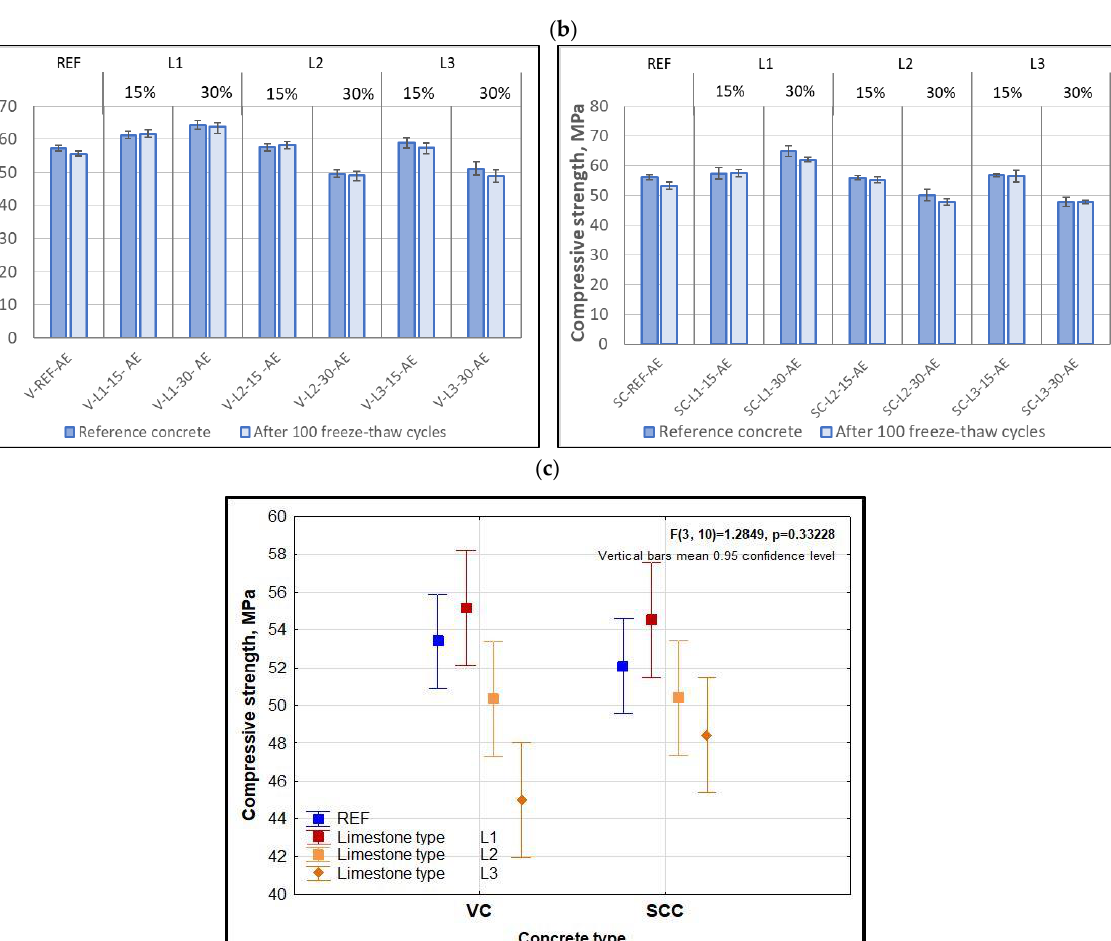
Figure 7. Compressive strength of ( a ) vibrated concrete and ( b ) self-compacting concrete, both with- out air-entraining admixture, with ( c ) ANOVA analysis of the effect of using limestone.